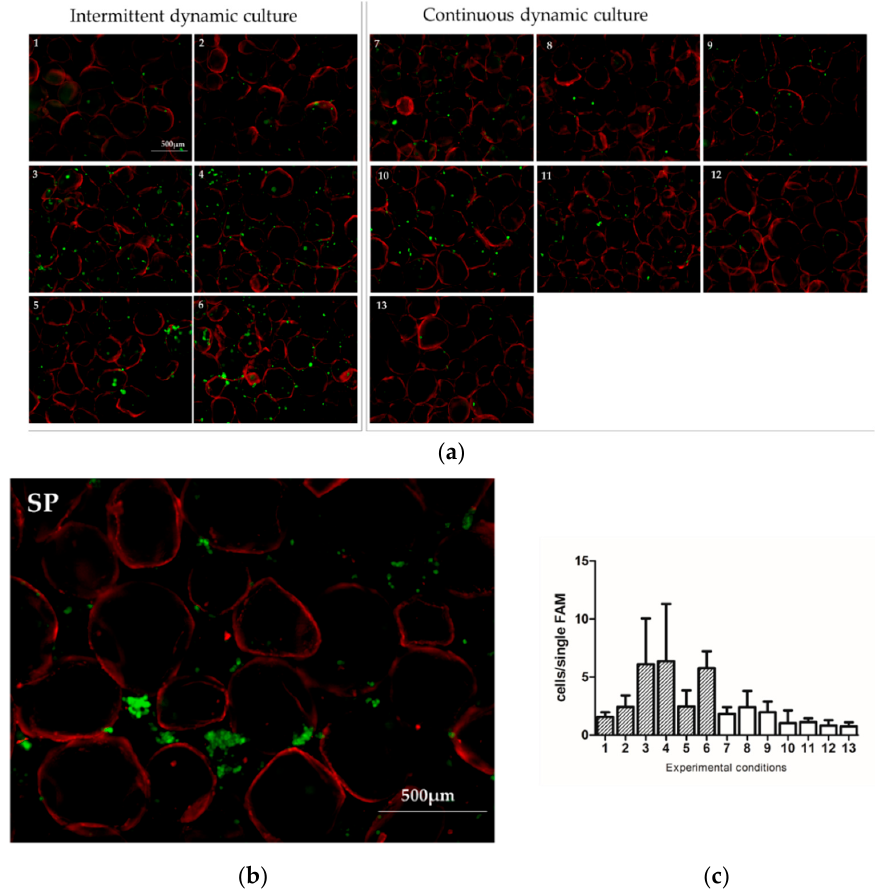
Figure 3. Representative images of Calcein stained cells (green) seeded on LFAMs (auto-fluorescent in red) with the 13 different protocols suggested by Design of Experiment (DoE) ( a ) (1: 20 RPM, 30 min, intermittent, 1000 µ L; 2: 20 RPM, 120 min, intermittent, 1000 µ L; 3: 10 RPM, 60 min, intermittent, 400 µ L; 4: 10 RPM, 120 min, intermittent, 400 µ L; 5: 5 RPM, 30 min, intermittent, 400 µ L; 6: 5 RPM, 90 min, intermittent, 1000 µ L; 7: 20 RPM, 60 min, continuous, 400 µ L; 8: 20 RPM, 90 min, continuous, 400 µ L; 9: 10 RPM, 30 min, continuous, 1000 µ L; 10: 10 RPM, 60 min, continuous, 1000 µ L; 11: 10 RPM, 120 min, continuous, 400 µ L; 12: 5 RPM, 30 min, continuous, 400 µ L; 13: 5 RPM, 120 min, continuous, 1000 µ L) and the Standard Protocol ( b ) (SP: 70 RPM, 120 min, continuous, 1000 µ L). Scale bar = 500 µ m. Semi-quantitative evaluation of Calcein-stained cells on the surface of LFAMs ( c